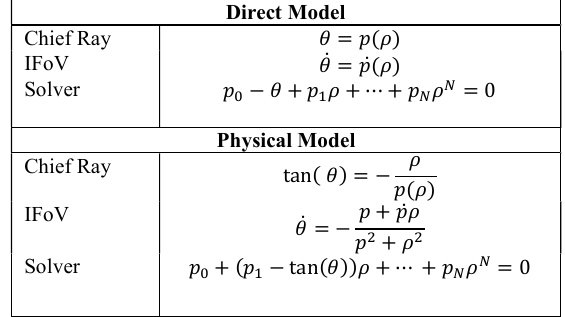
Table 2 Main equations of the simple and physical models